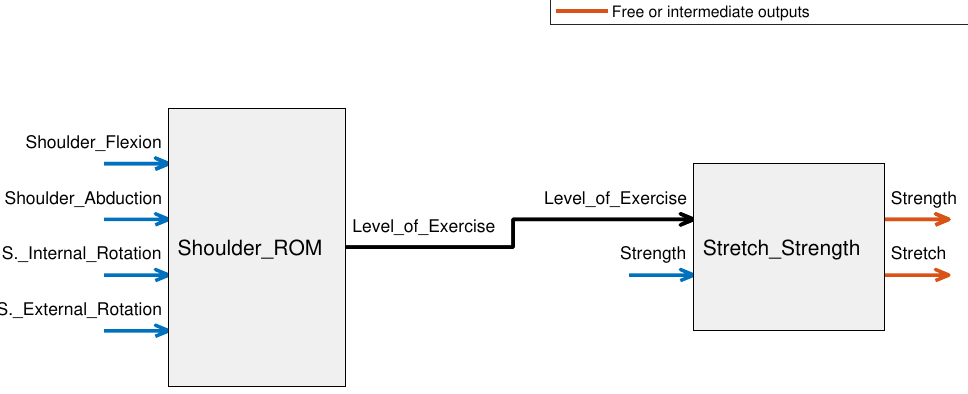
Figure 1. Block diagram for overall FIS illustrating the fuzzy tree structure where the output of the Shoulder_ROM FIS block (Level_of_Exercise) is input into the Stretch_Strength